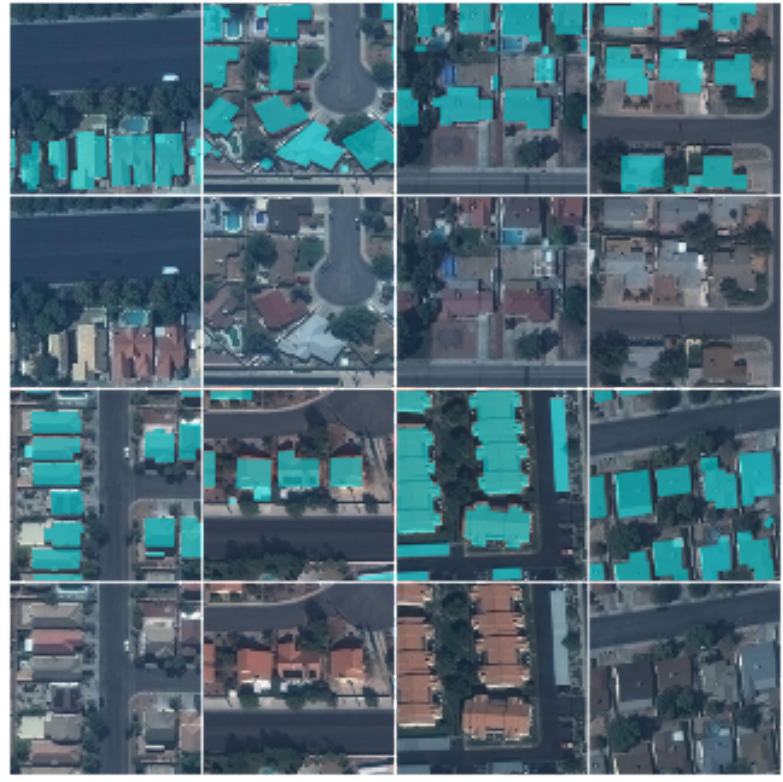
Figure 6. Samples of CrowdAI. The ground truth of buildings is in cyan.